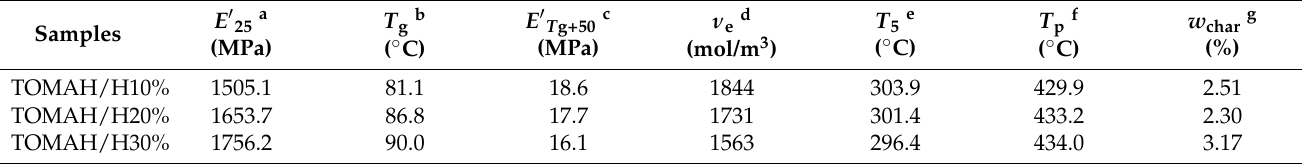
Table 3. Thermal properties of the cured TOMAH/H materials.